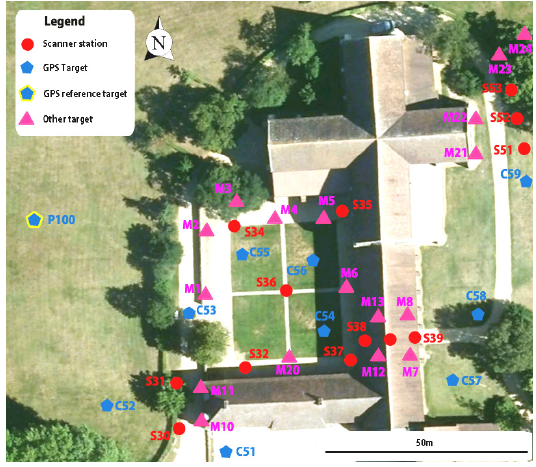
Figure 5. The third TLS campaign: laser stations and target (GPS and non georeferenced) locations.